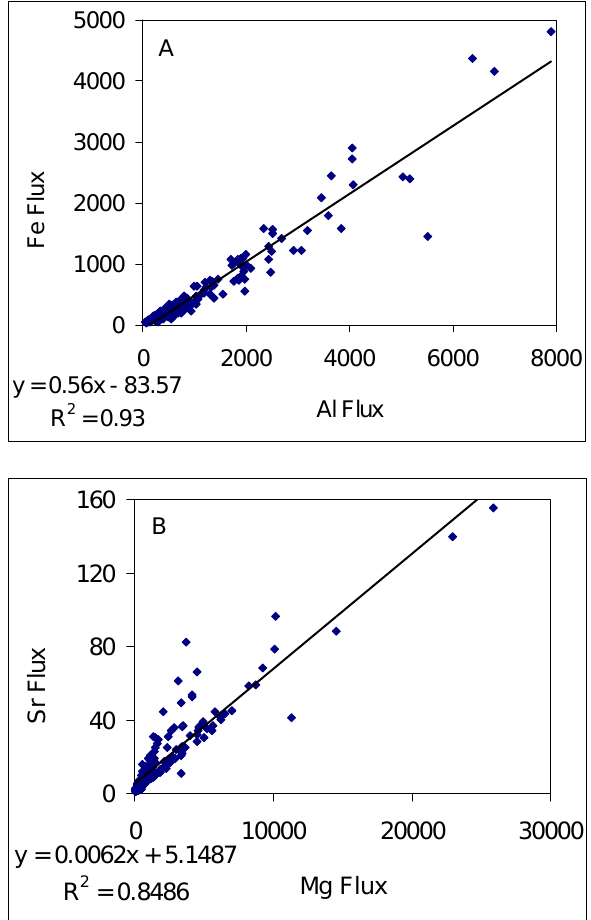
Fig. 5. Scatter plots of the rainfall flux data for Fe vs. Al, reflect- ing the contribution from mineral dust (A) , and Sr vs. Mg, reflect- ing the contribution from sea salt aerosols (B) . Correlation coeffi- cients ( R 2 ) are from linear regression analysis. All flux units are µg/m 2 per rain